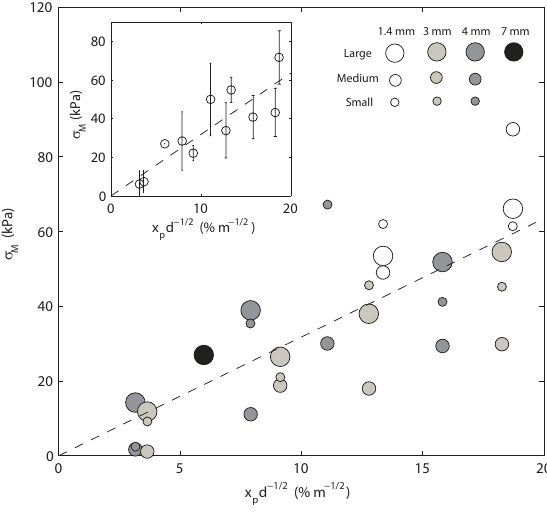
Figure 5. Macro-scale tensile stress σ M as a function of the para ffi n content x p divided by √ d . Inset: Averaged values. The dashed line stands for y = β x , with the fit parameter β = 3 . 2